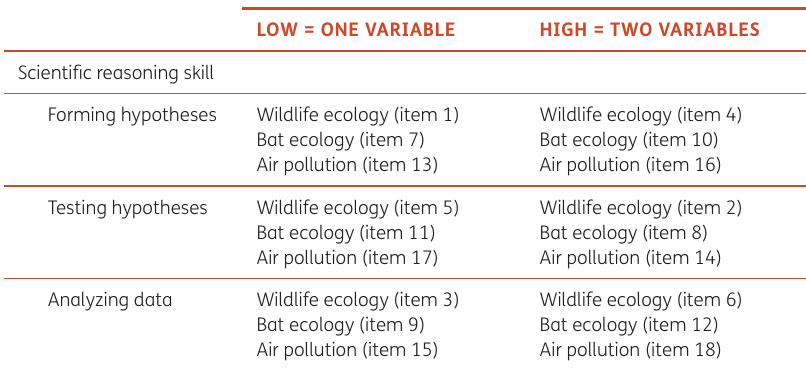
Table 1 Specification of item features for item numbers 1–18 in the development of the